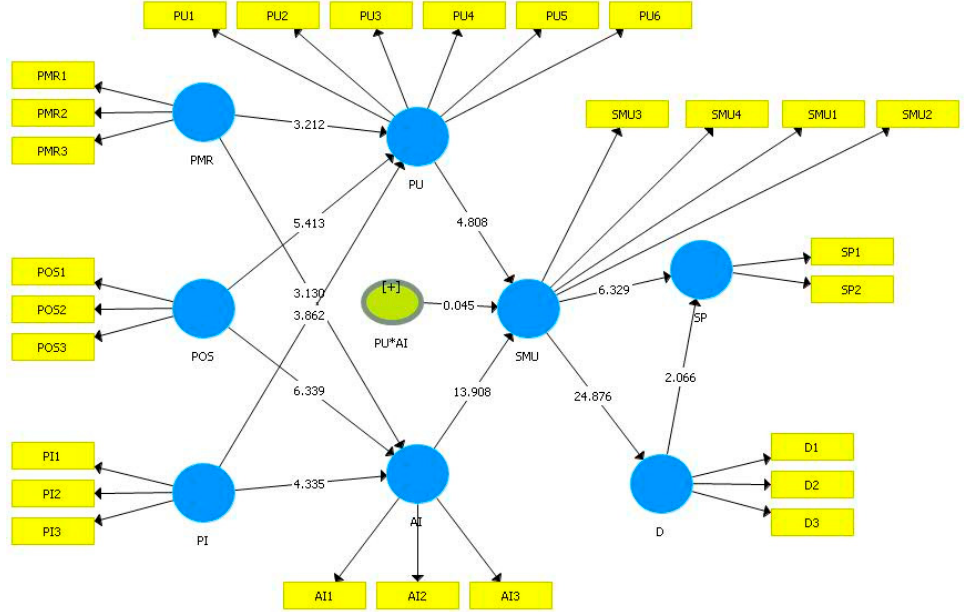
Figure 5. SmartPLS software output in significant coefficient mode.